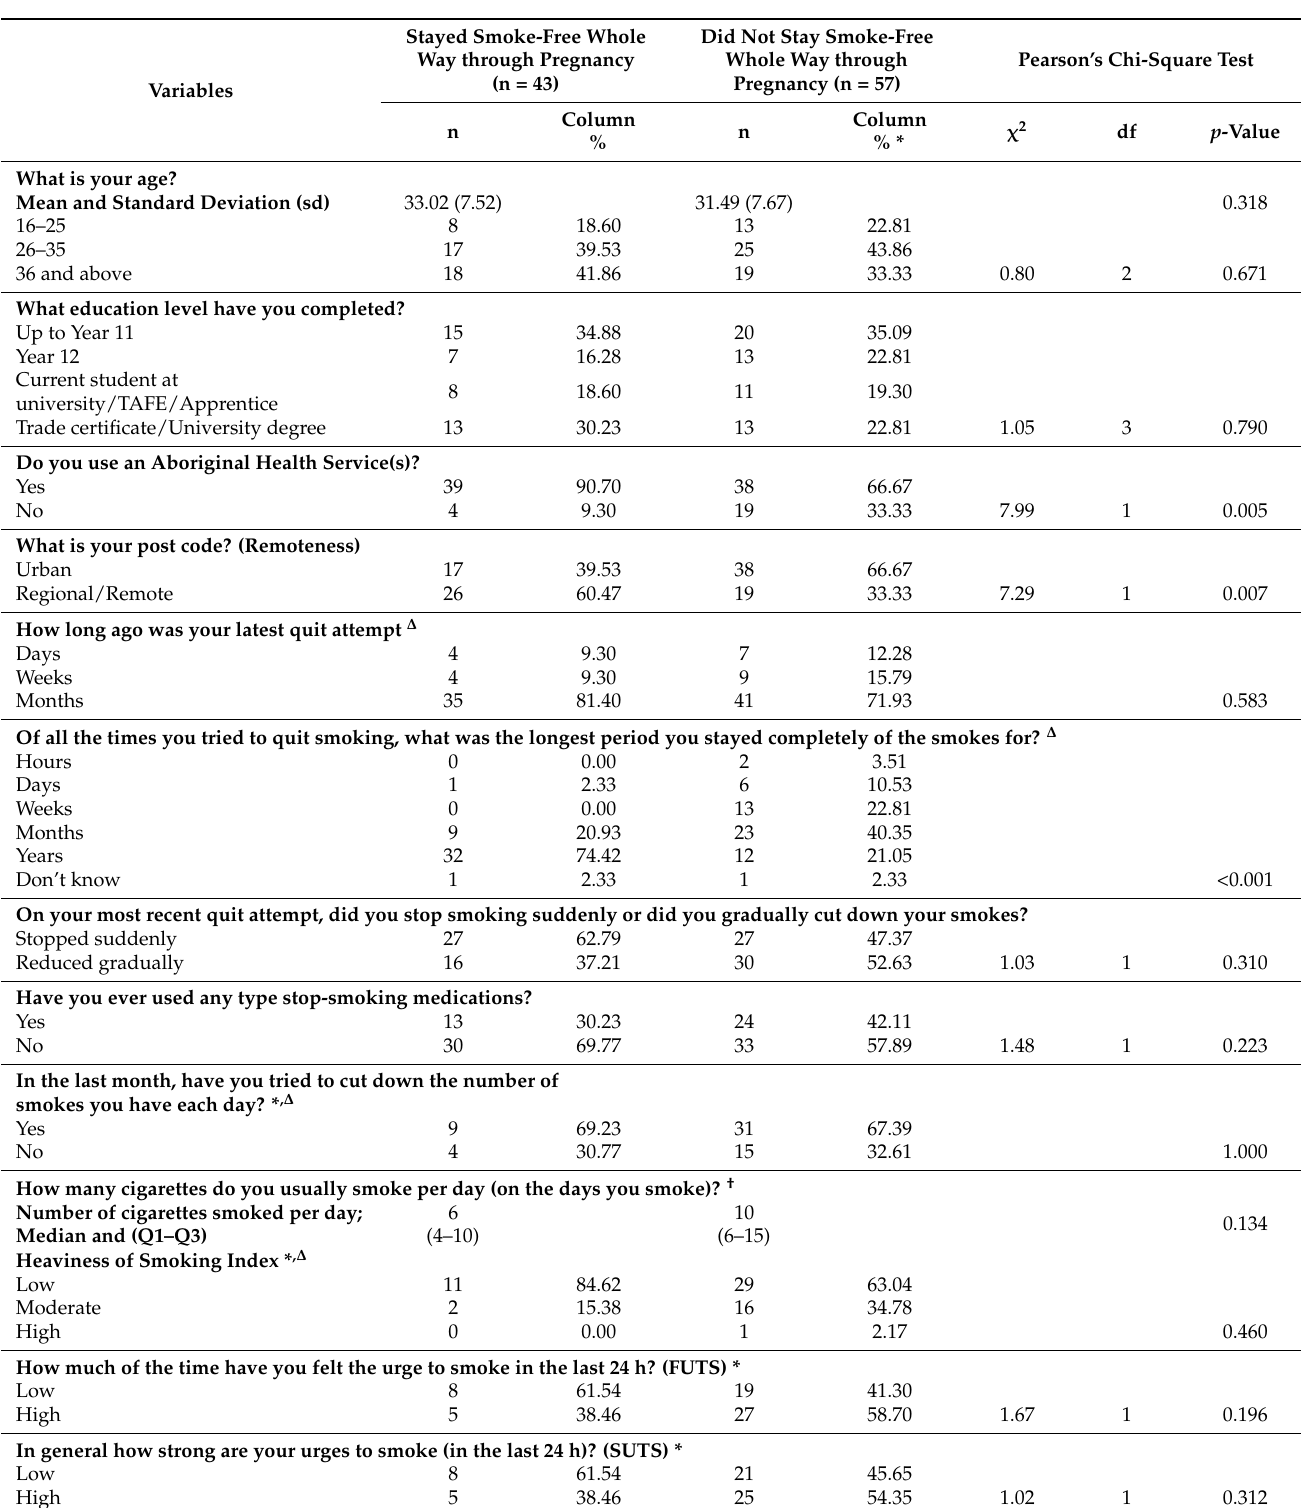
Table 2. Participant characteristics of those who stayed entirely smoke-free during pregnancy and those who did not (N =